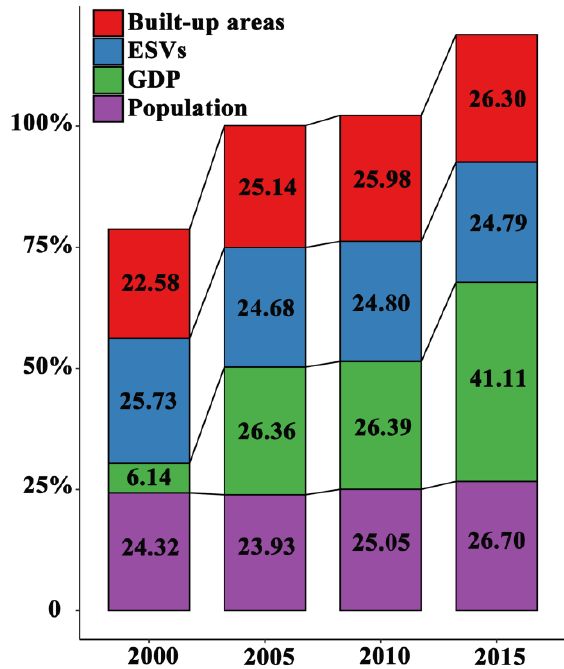
Figure 2. Variations in ESVs, population, GDP, and built-up areas from 2000 to 2015. Note: for comparability, each indicator was considered as a whole; from 2000 to 2015, the sum of each indicator was 100%, that is, in 2000, 2005, 2010, and 2015, the trend of each indicator can be estimated by comparing the proportion